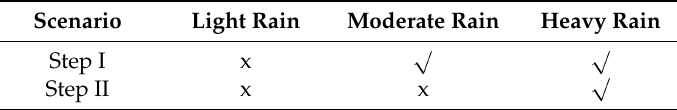
Table 3. Steps I and II in different